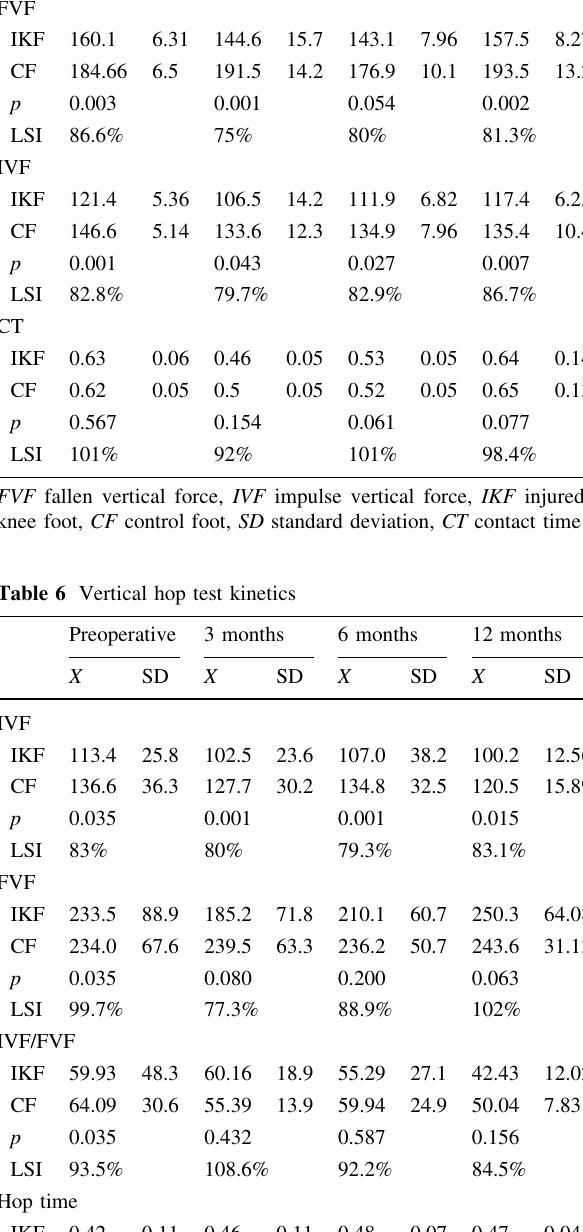
IVF impulse vertical force, FVF fallen vertical force, MVF maximum vertical force, IKF injured-knee foot, CF control foot, SD standard